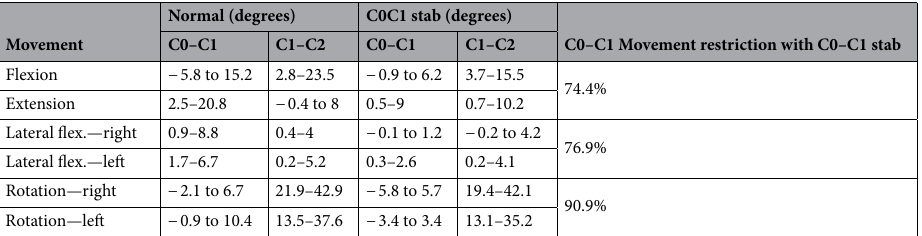
Table 1. Minimum and maximum intervertebral motion (in degrees) for C0–C1 and C1–C2 in the cardinal planes in both conditions: normal and C0–C1 stabilization (C0–C1 stab). These are the values for two specimens in each condition, and the rest of the specimens showed values between this range. The percentages show the C0–C1 movement restriction with C0–C1